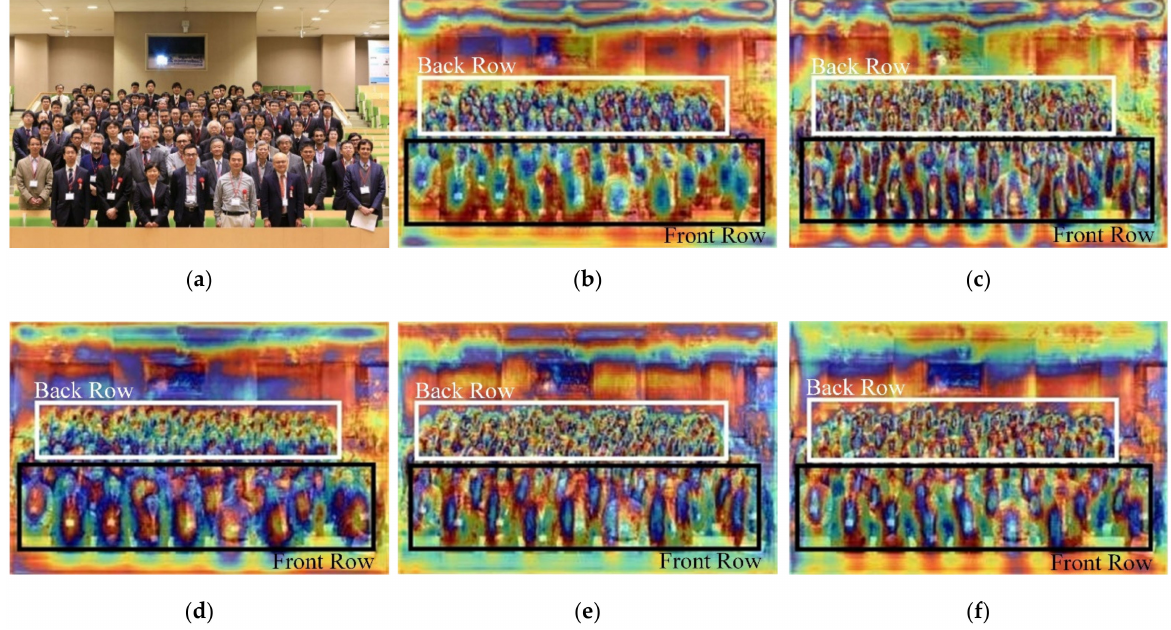
Figure 4. Comparisons of feature maps extracted by different networks. As shown in ( b ), the feature map extracted by ResNet50 and FPN is the worst, with unclear key features and contours. After the combination of ResNet50 and BiFPN ( c , d ), the features in the front row are better than ( b ): contours of features in the front row are gradually clearer, and features of key parts can be displayed clearly. ( e , f ) are feature maps extracted by our network. The only difference is that ( f ) uses general convolution. It can be seen that the contours and key parts of the features can be clearly represented, especially the features of the targets in the front row. The contours of features extracted by our network in the back row are also gradually separated and clear. Furthermore, we can find that the effect of general convolution on feature extraction network is better than that of separable convolution, comparing ( d ) with ( c ), ( f ) with ( e ). Under the same conditions, separable convolution has fewer parameters than general convolution. Therefore, it is usually used in some lightweight structures. Due to the purpose of improving the performance of the pedestrian detection system, the general convolution is utilized with the factor of parameters ignored. ( a ) Input Image, ( b ) ResNet50 + FPN(GC), ( c ) ResNet50 + BiFPN(SC), ( d ) ResNet50 + BiFPN(GC), ( e ) ResNet50 + Double FPN(SC), ( f ) ResNet50 + Double